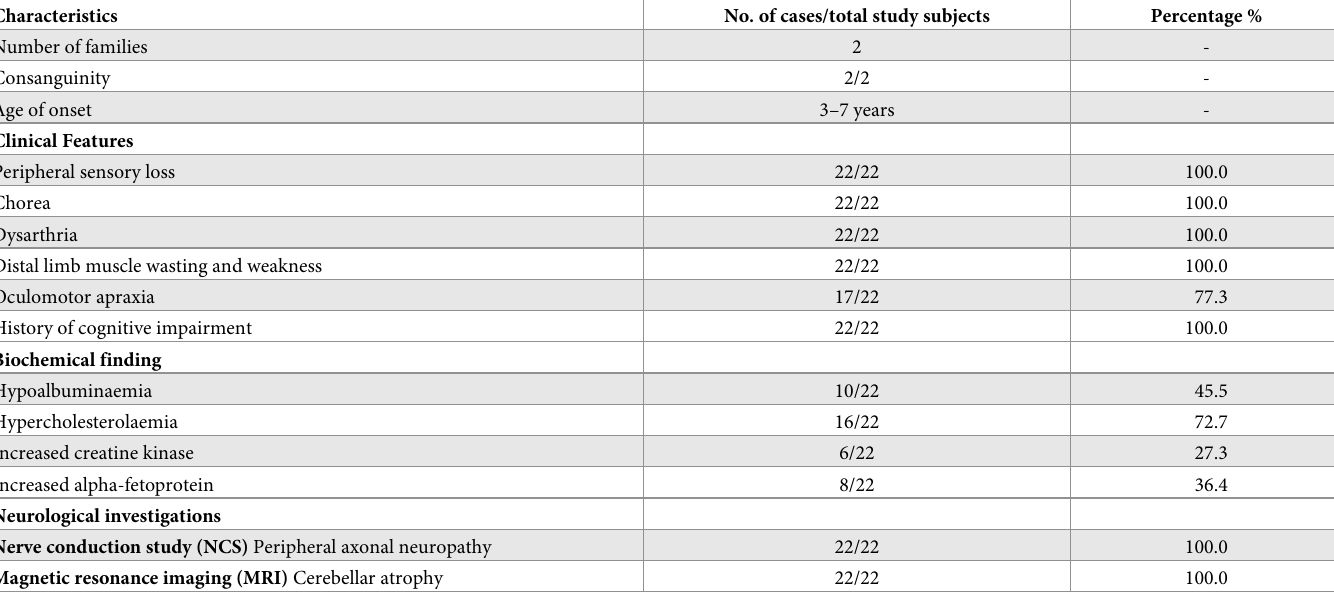
Table 1. Summary of the major clinical signs for the 22 AOA1 patients in the